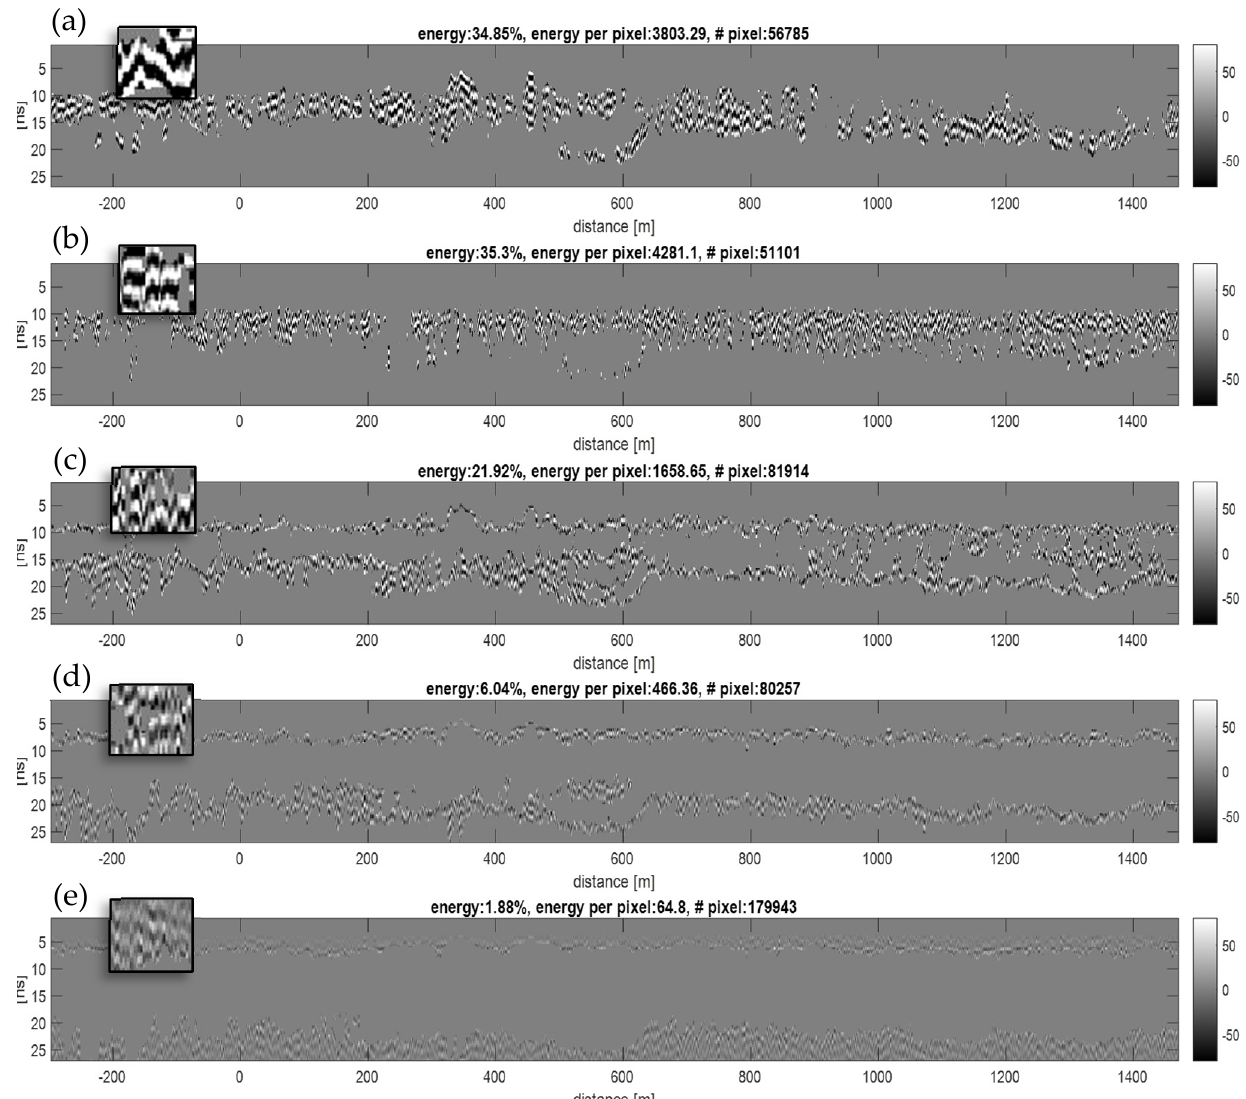
Figure 10. Five examples of automatically extracted segments of a radargram characterized by typical textures: ( a ) low-frequency and high-amplitude regions, ( b ) medium-/high-frequency and high-amplitude regions, ( c ) medium frequency and medium amplitudes, and ( d ) medium- and ( e ) low-amplitude regions.